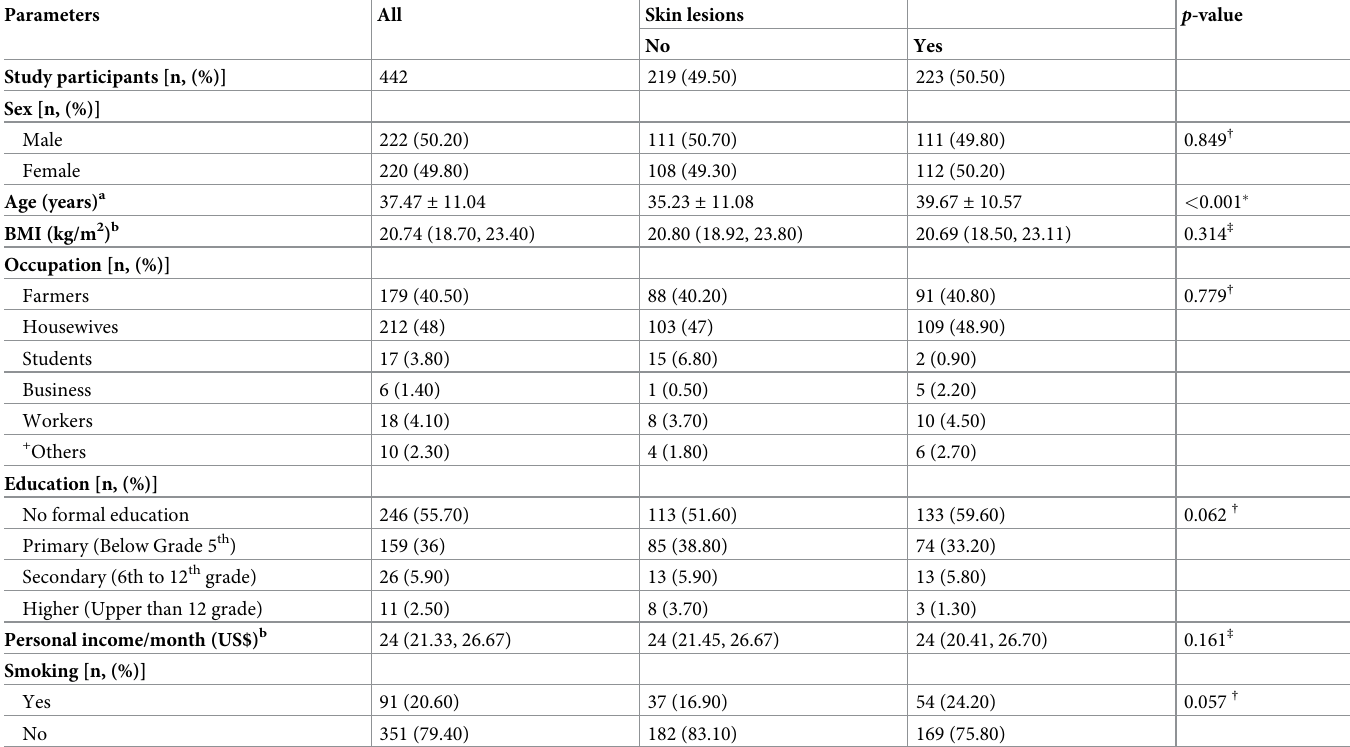
Table 1. Descriptive characteristics of the groups of participants with and without skin